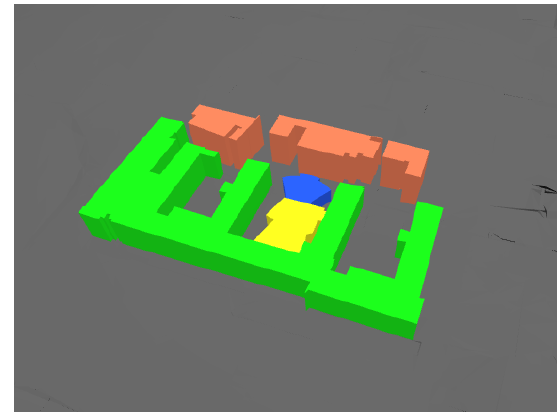
Figure 8. Visualisation of above query via QGIS. Object painted in red belong to the “Red Center” building (not in query result). Query results include “Keith Burrows Theatre” in blue, “Physics Theatre” in yellow and “Old Main” building in green.